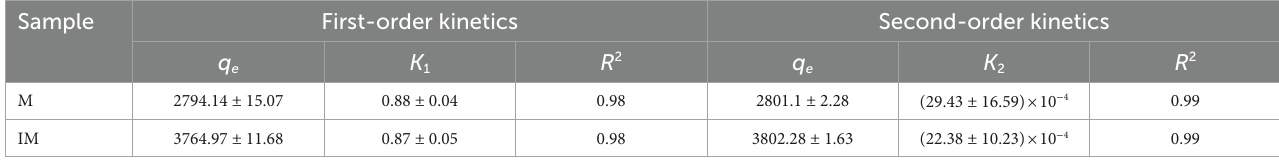
TABLE 3 Atrazine adsorption kinetics parameters described on carrier materials (M) and immobilized carrier materials (IM) by the pseudo-first-order kinetics model ( R 2 = 0.98) and pseudo-second-order kinetics model ( R 2 = 0.99). Sample First-order kinetics